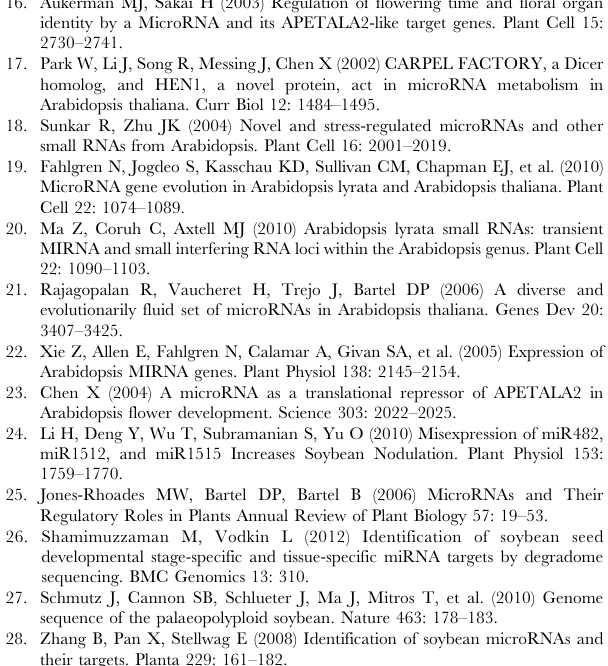
Figure S2 Soy-miR15/49 Gene Cluster Region. A 110 kb region on chromosome 3 contains multiple miRNA genes of the soy-miR15/49 family. Each of their miRNA fold-back structures are embedded in inverted repeat sequences (IR1-7) drawn as blue diamonds to represent their inverted structures. The inverted repeat sequence containing an indel in its middle region is illustrated as an orange diamond (IR8). The phylogenetic tree presented on the top indicates the evolutionarily relationship among those IRs. Trun- cated IRs homologous to the full-length IRs are shown as green triangles. Four genes (gray and purple rectangles) are located in this repetitive region. The reticulon protein genes are embedded in the 12 kb duplicated regions (light blue rectangle). The direct repeat region also contains a solo LTR (black rectangle). Figure S3 Global Topology of miRNA-target Networks. The conserved and non-conserved miRNAs are represented by red and blue circles, respectively. Target genes that were categorized into functional bins are shown. Targets encoding proteins related to RNA metabolism (pink circles), Ubiquitin based protein degradation (green circles), receptor kinase families (orange circles), secondary metabolism (turquoise circles), lipid metabolism (yellow circles) are distinguished from all other targets (light blue circles). Thick black edges connecting nodes indicate network overrepresented by cotyledon miRNA targets in prefer- entially regulated biological pathways. Figure S4 Global Topology of miRNA-Biological Path- way Networks. The conserved and non-conserved miRNAs were indicated by red and blue circles, respectively. Their targeted biological pathways are shown by pink circles representing biological pathways related to RNA metabolism, green circles standing for Ubiquitin based protein degradation pathways, orange circles denoting receptor kinase families and light blue circles representing all remaining pathways.